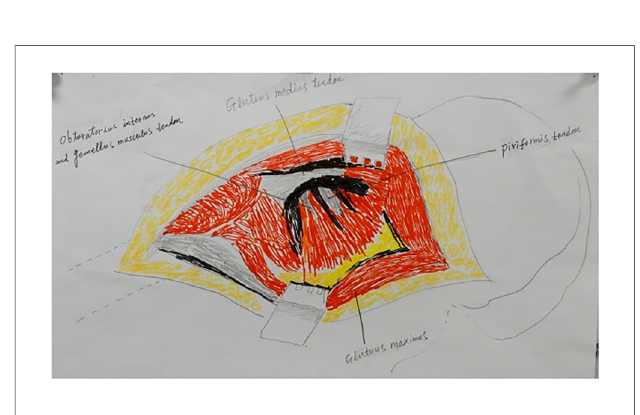
FIGURE 2 Exposing the femoral neck. The piriformis and obturator internus muscles and the superior and inferior gemellus tendons were severed to expose the femoral